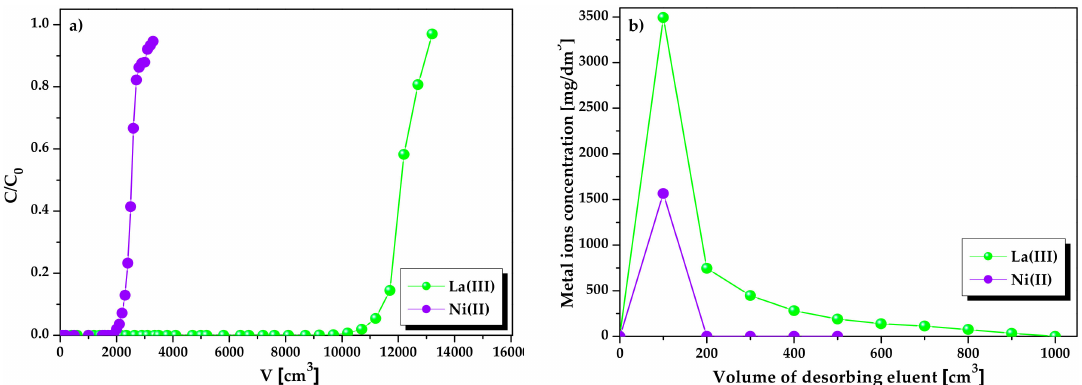
Figure 12. ( a ) Breakthrough curves comparison of La(III) and Ni(II) ions sorption for Lewatit Monoplus SP112 and ( b ) Elution curves for La(III) and Ni(II)